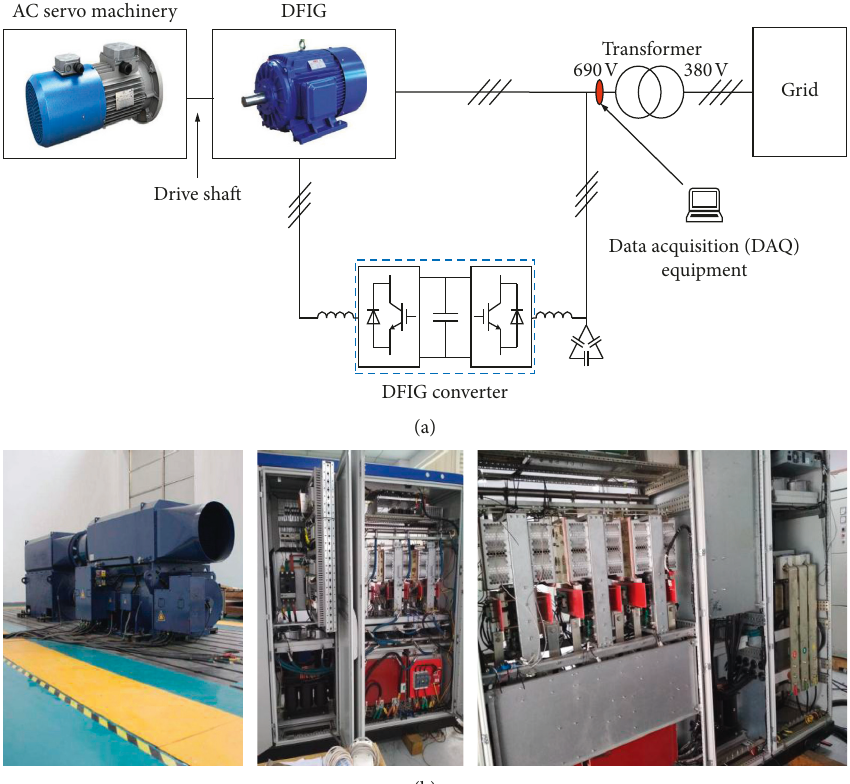
Figure 15: (a) Schematic diagram and (b) physical photograph of the experimental